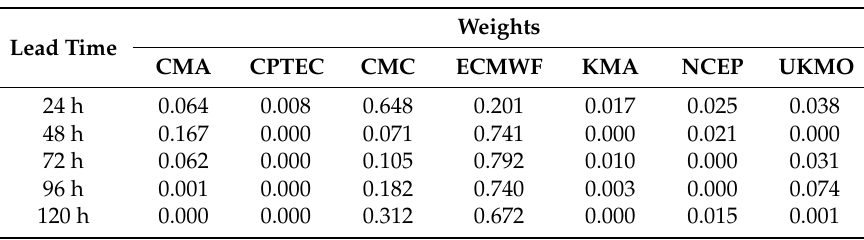
Table 2. Weights of seven contribution components for BMA GE probabilistic runoff forecasts. Owing to spatial confinements, this table shows only the weights at lead times of 24 h, 48 h, 72h, 96 h, 120 h.